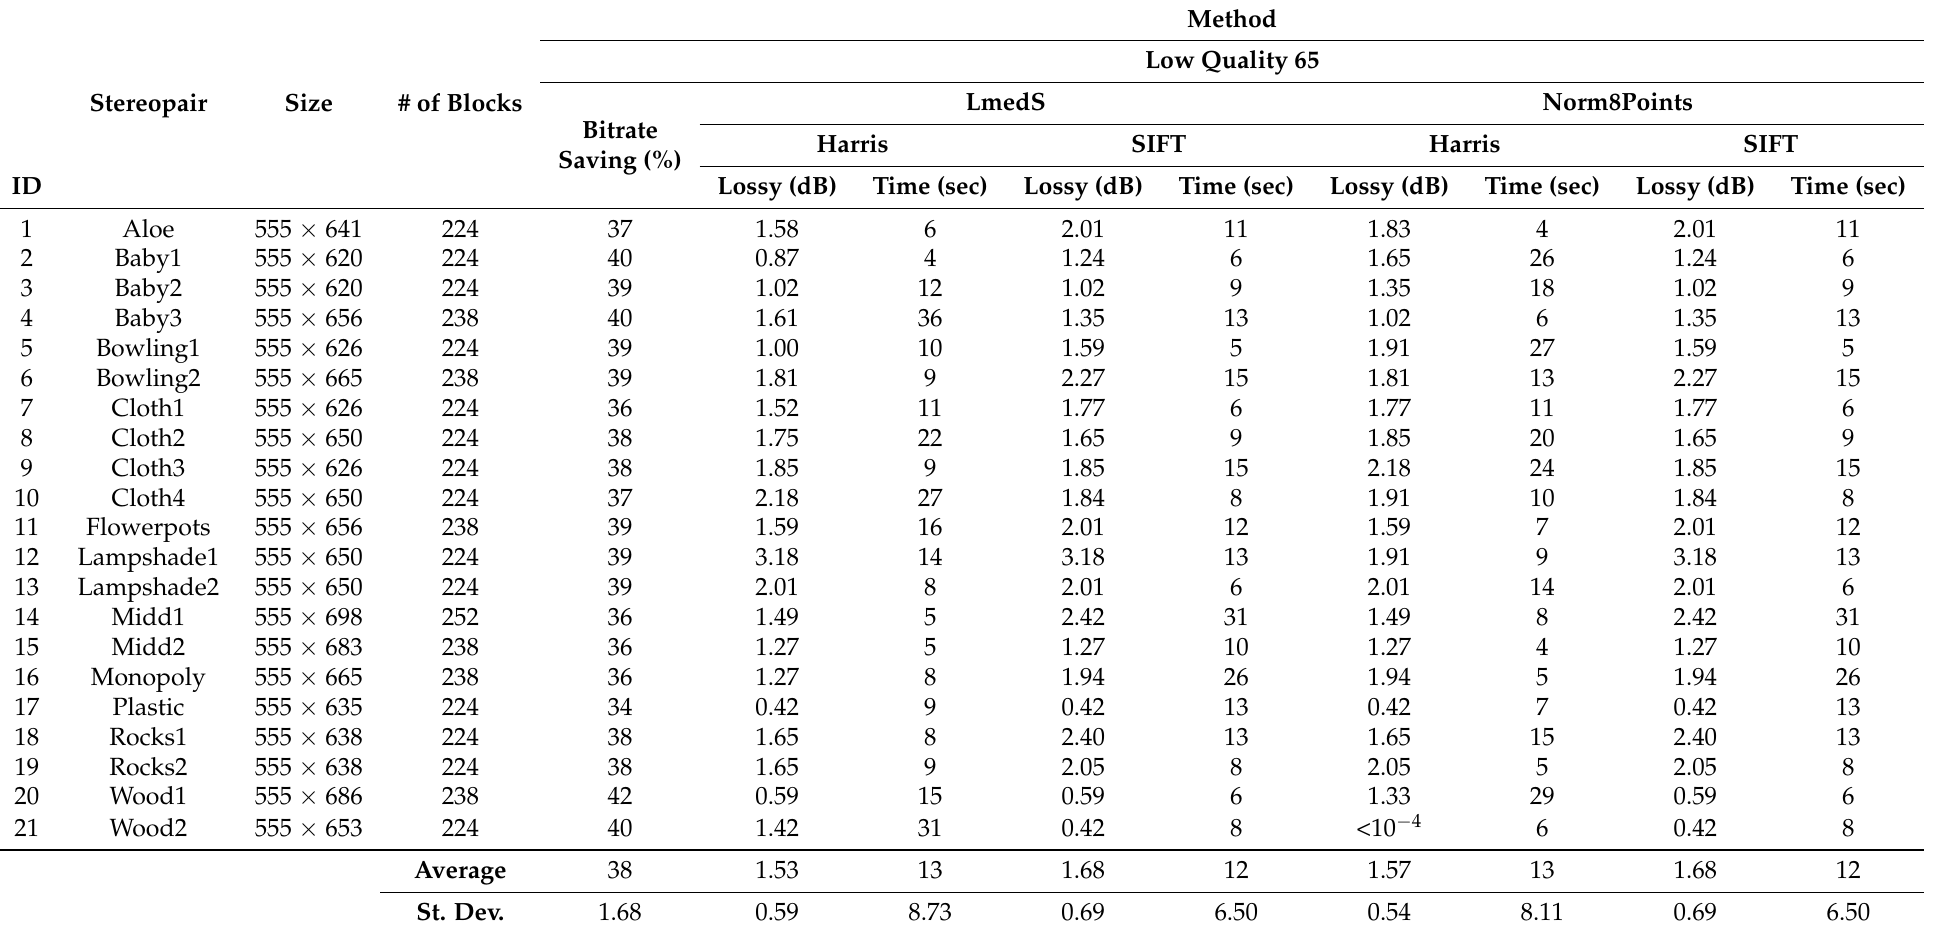
Table 4. Results on the Middlebury-scenes 2006 dataset, considering a low quality of